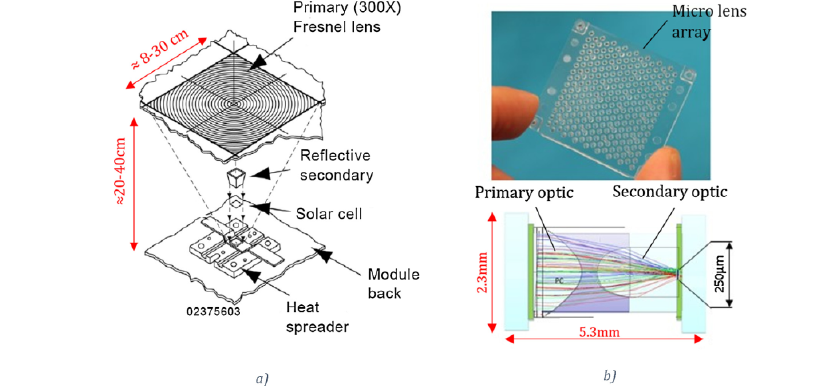
Figure 45. From Concentrated Photovoltaics (CPV) to micro-concentrator photovoltaics (micro-CPV) ( a ) Typical large concentrator photovoltaic with Fresnel lens and heat spreader. ( b ) Schematics of a micro-CPV cross-section without a heat spreader [78]. Reprinted from J. L. Cruz-Campa et